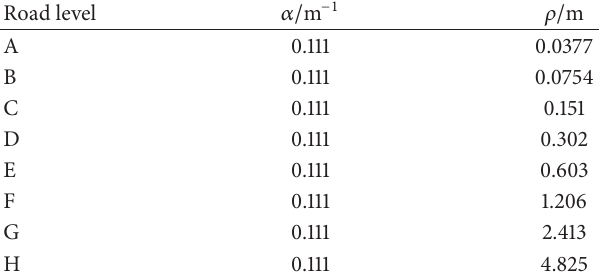
Table 1: Values of road model parameters. Road